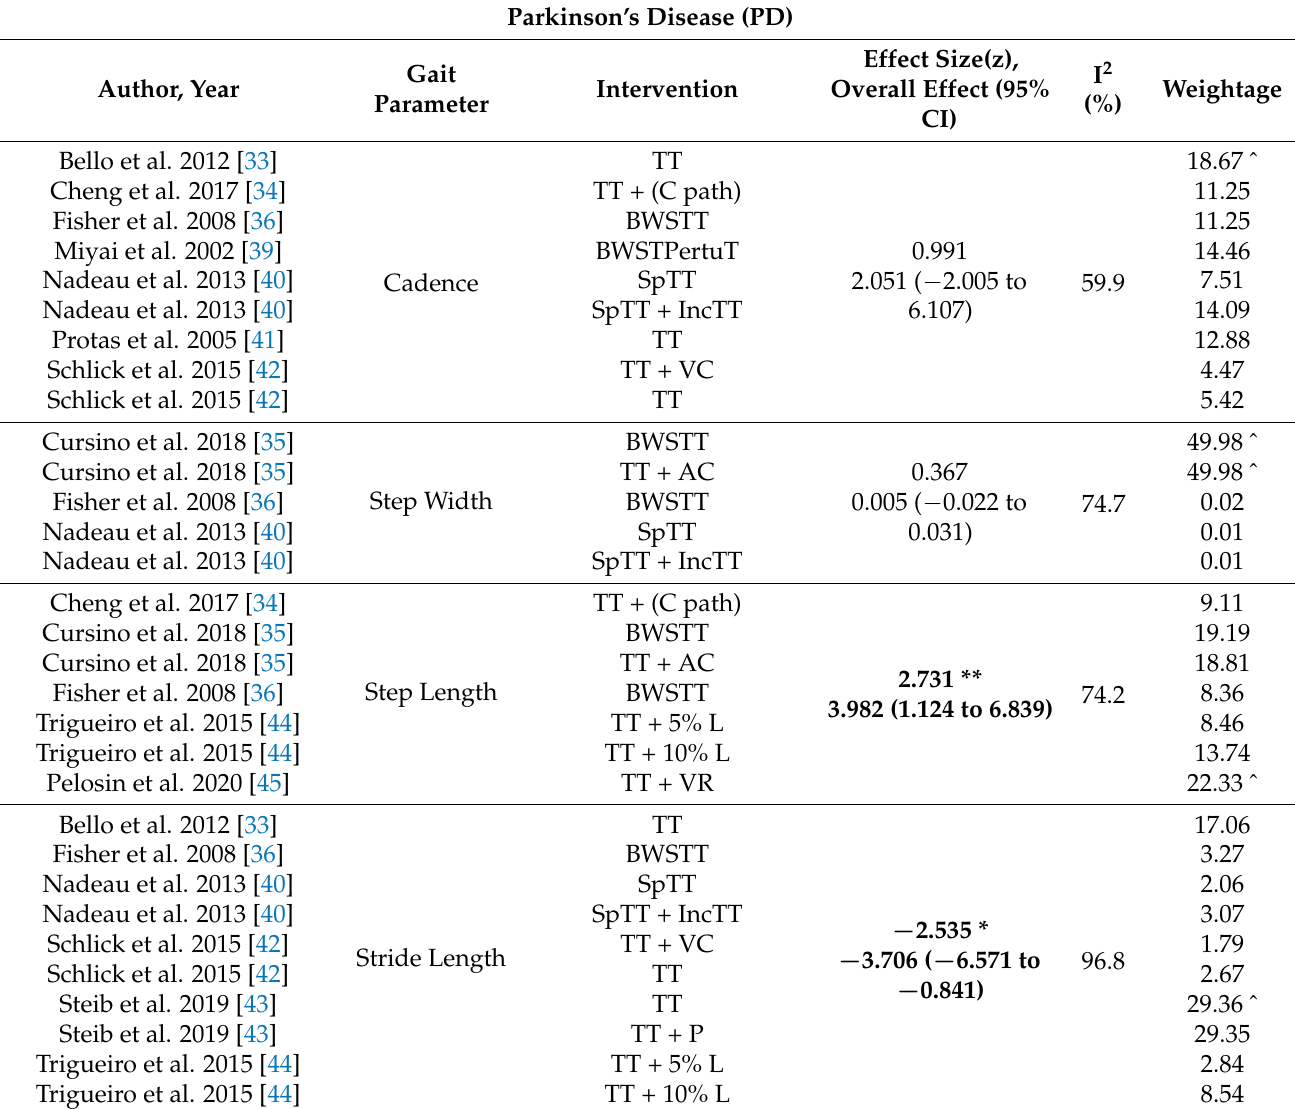
Table 3. Meta-analysis in people with